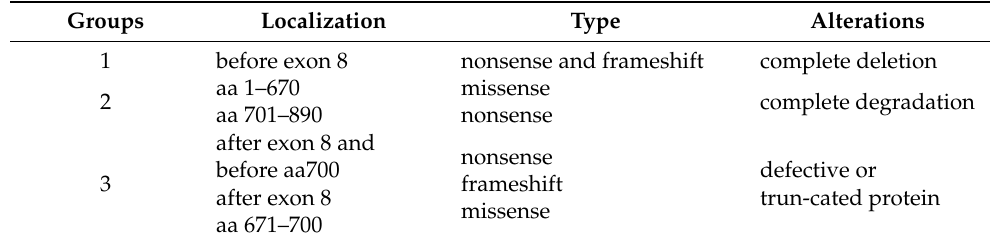
Table 2. Classification of Wolfram Syndrome type 1 mutations [23]. Adapted from Rigoli et al. [46]. Groups